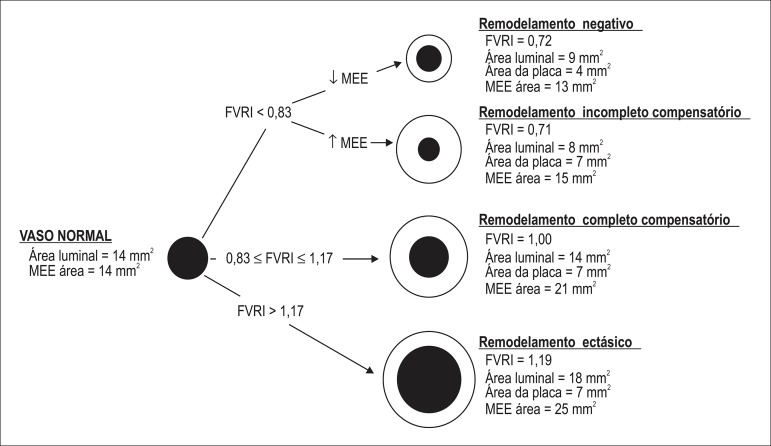
Possible remodeling outcomes of a normal coronary vessel after the occurrence
of atherosclerotic plaque. The figure shows the remodeling patterns classified
according to the algorithm based on the fractional vessel remodeling index
(FVRI). The numeric values are only illustrative. EEM: External elastic
membrane.